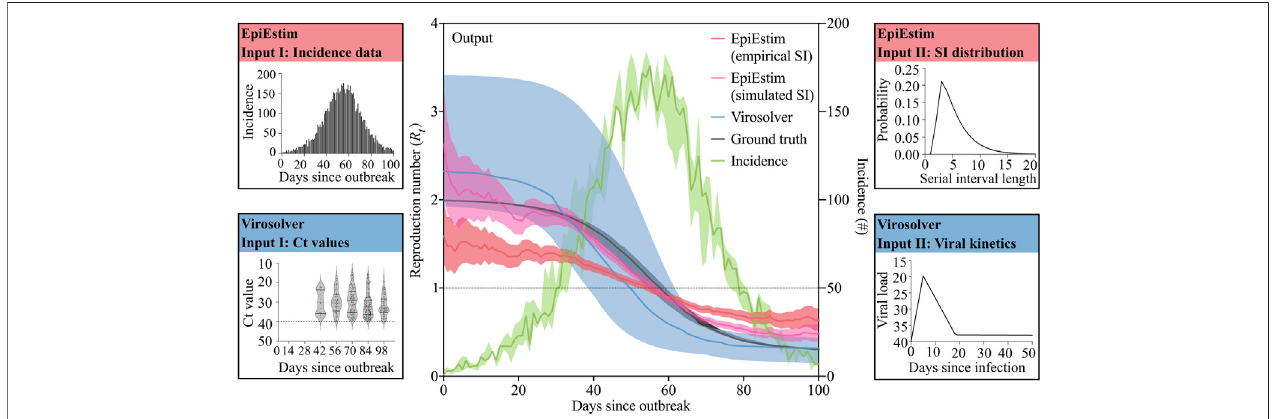
FIGURE 2 | A schematic illustrating how our simulation platform generates a comparison of the estimated R t from EpiEstim and virosolver . Incidence data and ground truth were generated from 100 simulations based on the SEIR model (green/gray line and shaded ribbon show mean and the range). Estimates of R t were obtained using EpiEstim (red line and shaded ribbon show posterior median and 95% CrI using mean incidence data) and virosolver (blue line and shaded ribbon show posteriormeanand95%CrI usingCt valuemodel), respectively. EpiEstim using theempirical valueofserialinterval distribution [18]and thesimulated serialinterval distribution are denoted by EpiEstim (empirical SI) and EpiEstim (simulated SI),